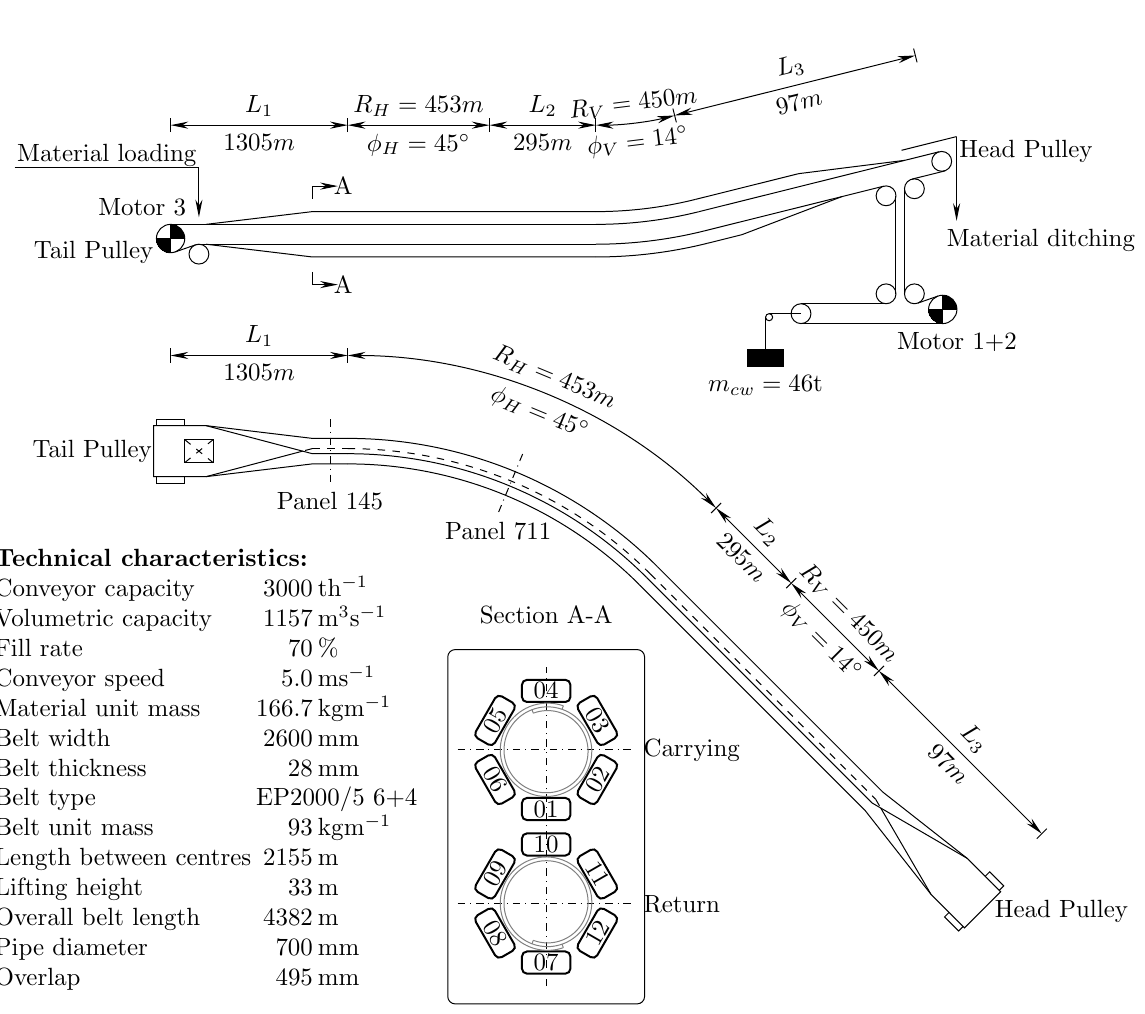
sections (vertical and horizontal) the panel spacing is